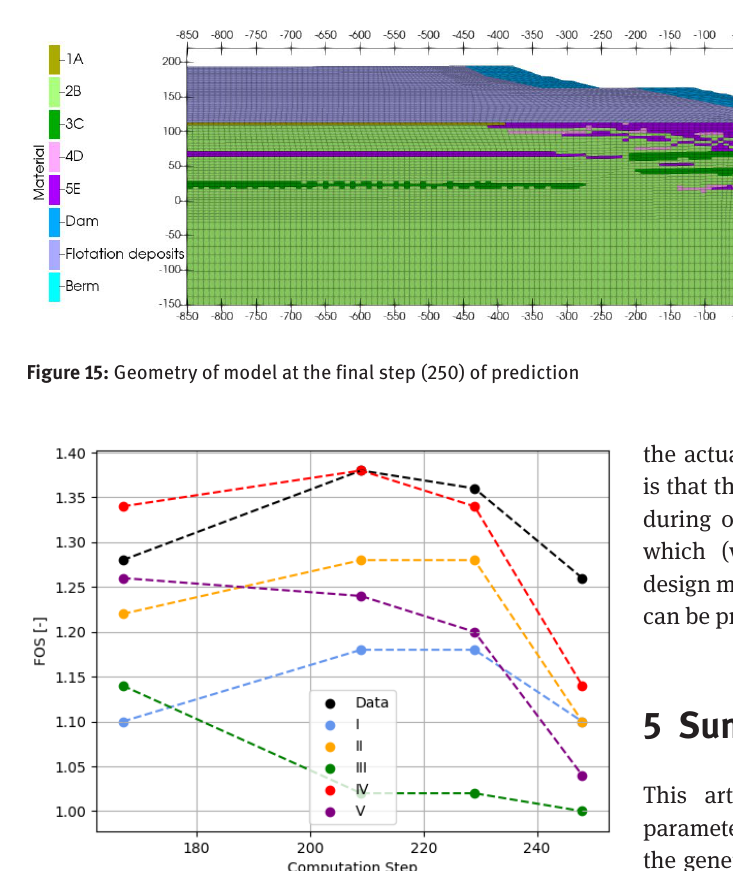
Figure 14: Geometry of model at the intermediate step (230) of prediction.